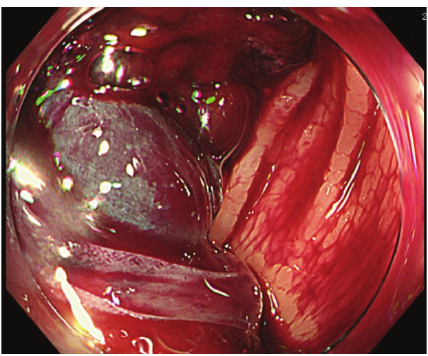
Figure 2: Colonoscopy showing huge submucosal hematoma in the sigmoid colon.